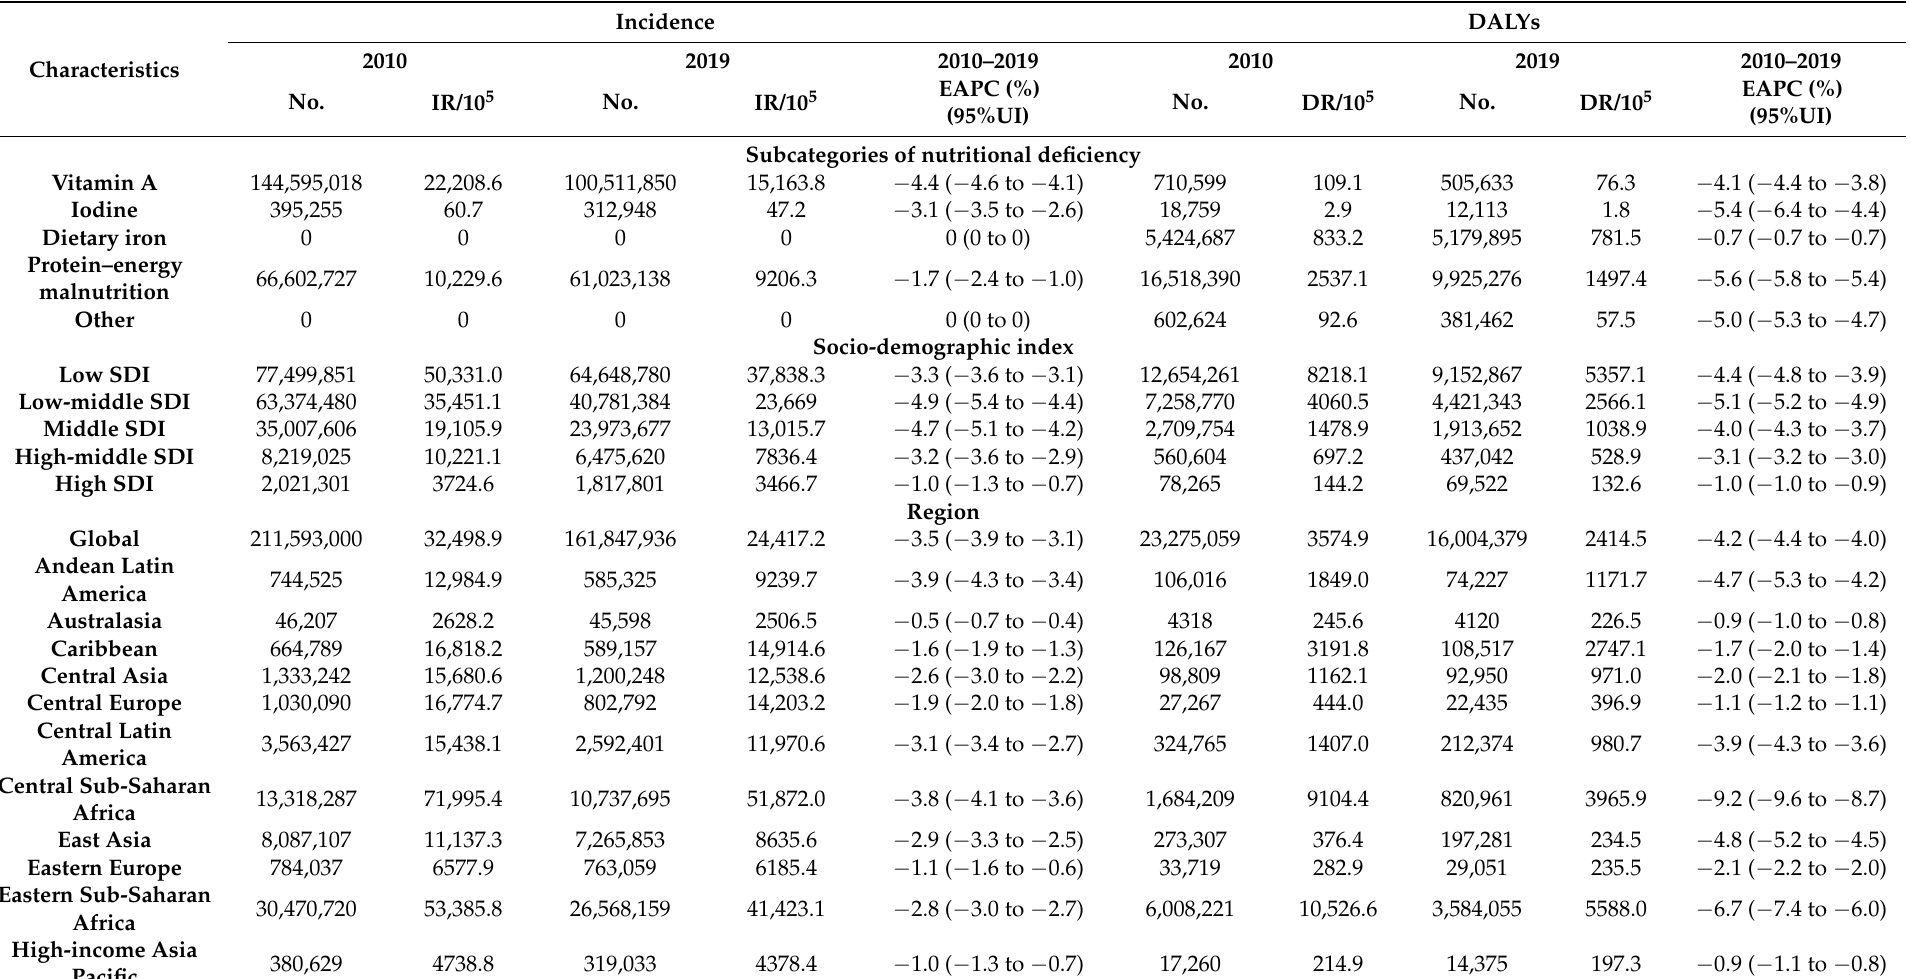
Table 1. The number, rate and temporal trend of incident and DALYs cases among children under 5 years of age, by subcategories, socio-demographic index and regions,